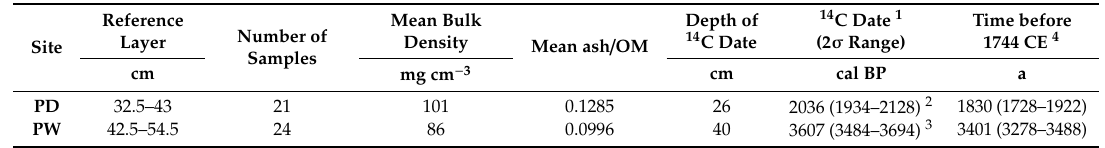
Table 1. Data for calculation of losses at PD and